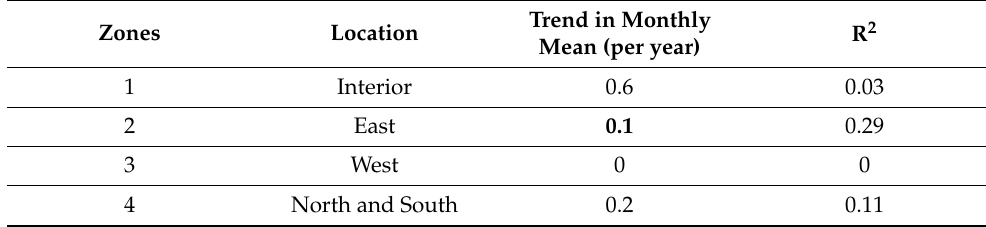
Table 5. Trends in monthly means per year per zones. Values in bold are significant at the 95% level. R 2 is the coefficient of determination and represents the proportion of variance explained by the trend.